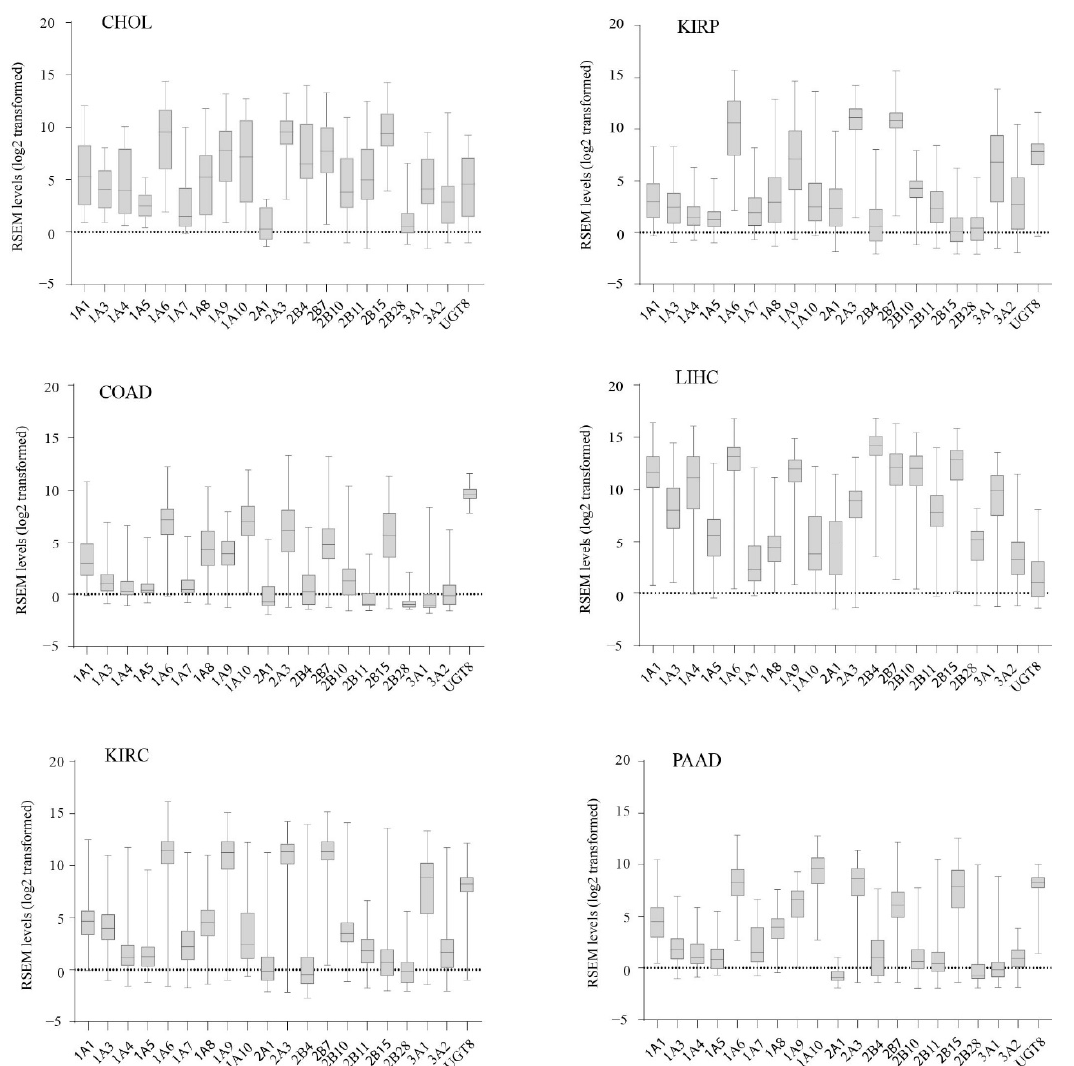
Figure 1. The expression profiles of UGT genes in six different types of TCGA cancers. The log2-transformed expression levels (RSEM values) of UGT genes in six TCGA cancer types (CHOL, COAD, KIRC, KIRP, LIHC, PAAD) are presented using the box-and-whisker plots that show the distribution of the expression levels (minimum, first quartile, median, third quartile, and maximum) in each of these cancers.